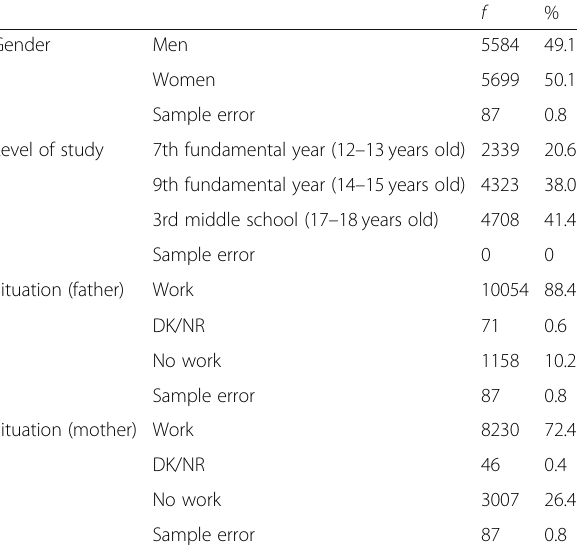
Table 2 Sample description, gender, level, and employment situation of parent